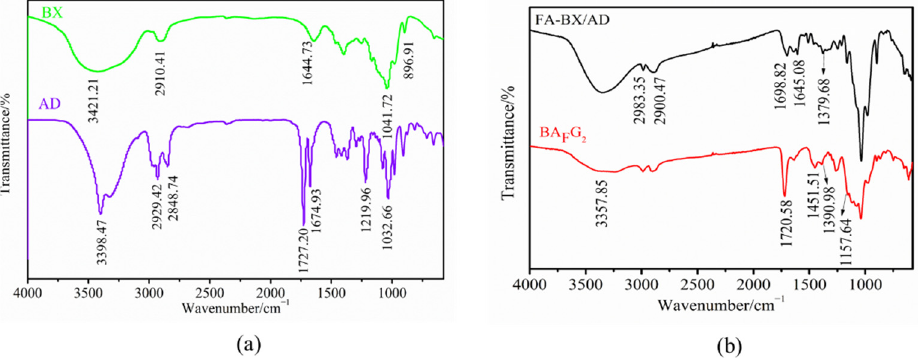
Figure 2. ( a ) IR spectrum of BX and AD. ( b ) IR spectrum of FA-BX/AD and BA F G 2 .